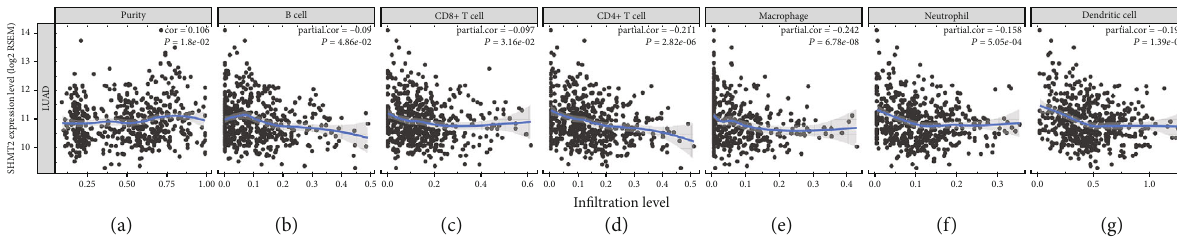
Figure 9: Correlation between SHMT2 expression and immune cell in fi ltration in LUAD from TCGA sample. Tumor purity, B cell abundance, CD8+T cells, CD4+T cells, macrophages, neutrophils, and dendritic cells relative to SHMT2